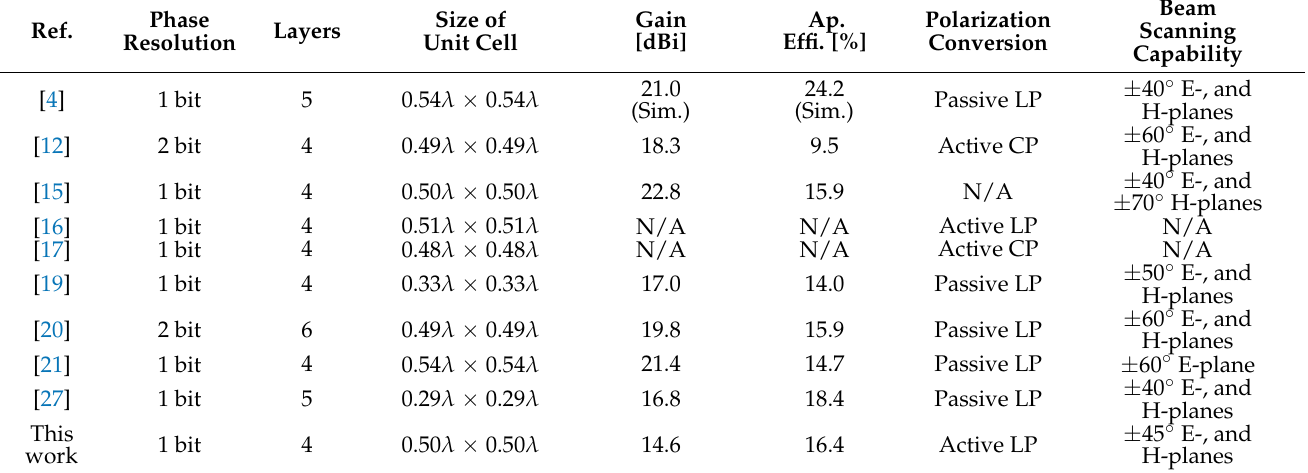
Table 4. Performance comparison with previous similar